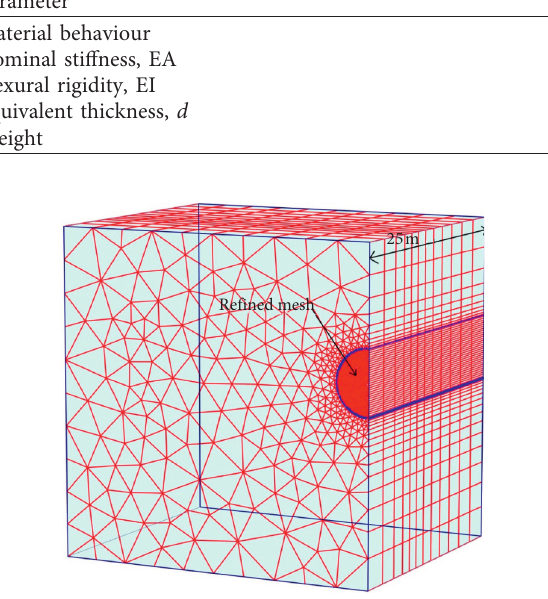
Figure 2: Mesh Generation. Coarse mesh is generated throughout the model and refined inside the tunnel.